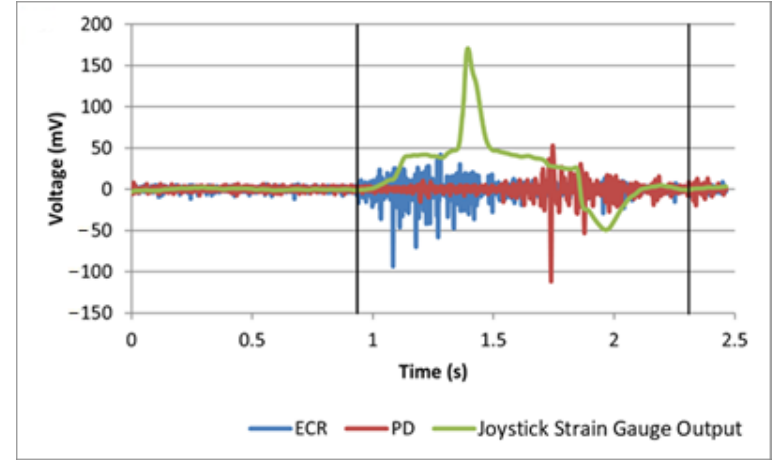
Figure 4. EMG data clipped using joystick strain gauge output using custom Matlab code. Representative example shown with extensor carpi radialis (ECR) and posterior deltoid (PD) EMG output. Vertical lines indicate where data were clipped.